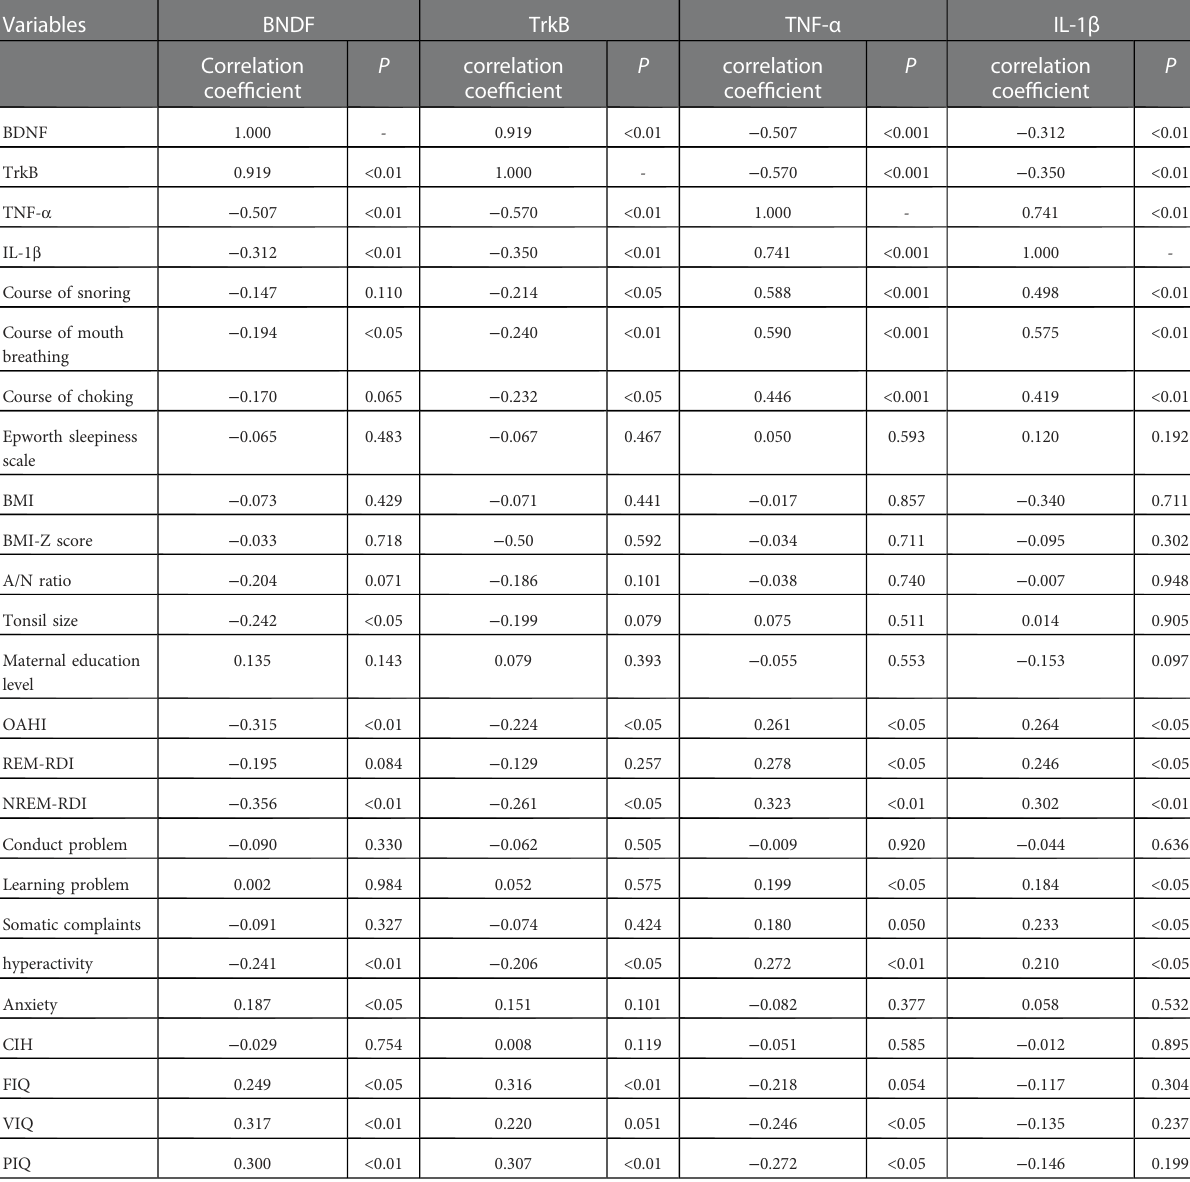
TABLE 5 Correlation analysis between baseline characteristics, in fl ammatory indicators, behavioral and cognitive parameters.